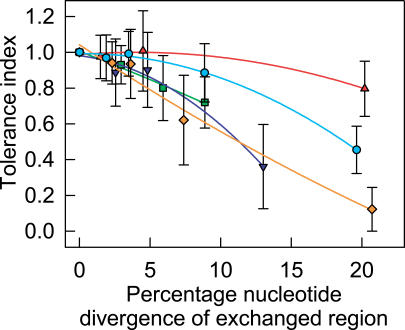
Tolerance of Recombination in MSV Differs According to the Genome Region Involved and the Degree of Divergence between Exchanged SequencesEach plotted point represents a Ti value calculated as the average fitness of a pair of recombinant viruses with reciprocally exchanged MP genes (cyan circles), CP genes (orange diamonds), Rep genes (blue inverted triangles), SIR (red triangles), or LIR (green squares) divided by the average fitness of their parental viruses. Error bars represent the standard deviations of Ti values. Curved lines represent quadratic regressions of Ti values against parental SIR, MP, LIR, CP, and Rep nucleotide sequences.